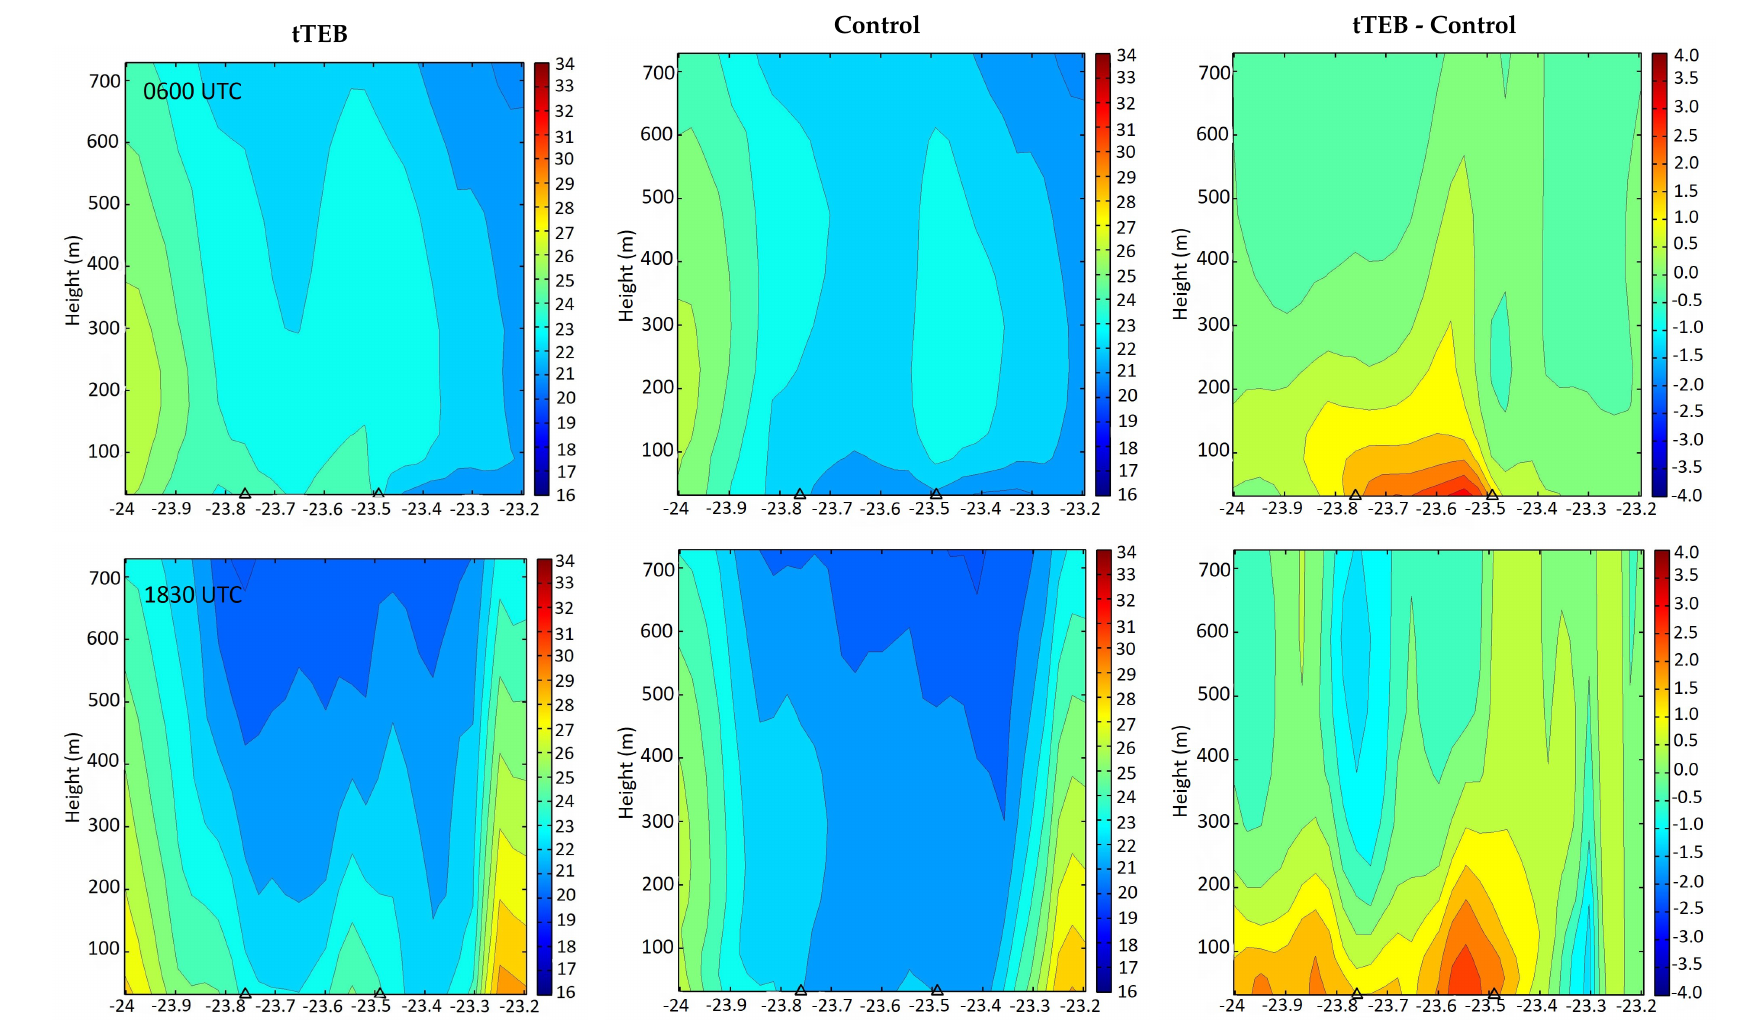
Figure 12. Vertical cross section of mean air temperature ( ◦ C) between 46.90 ◦ W to 46.42 ◦ W at 06 UTC (03 LT) (first row), 1830 UTC (1530 LT) (second row) along the latitude. The figure shows the results of the tTEB experiment (first column), the control experiment (second column) and the differences between both experiments (third column). Triangles indicate the extension of urban canopy of the